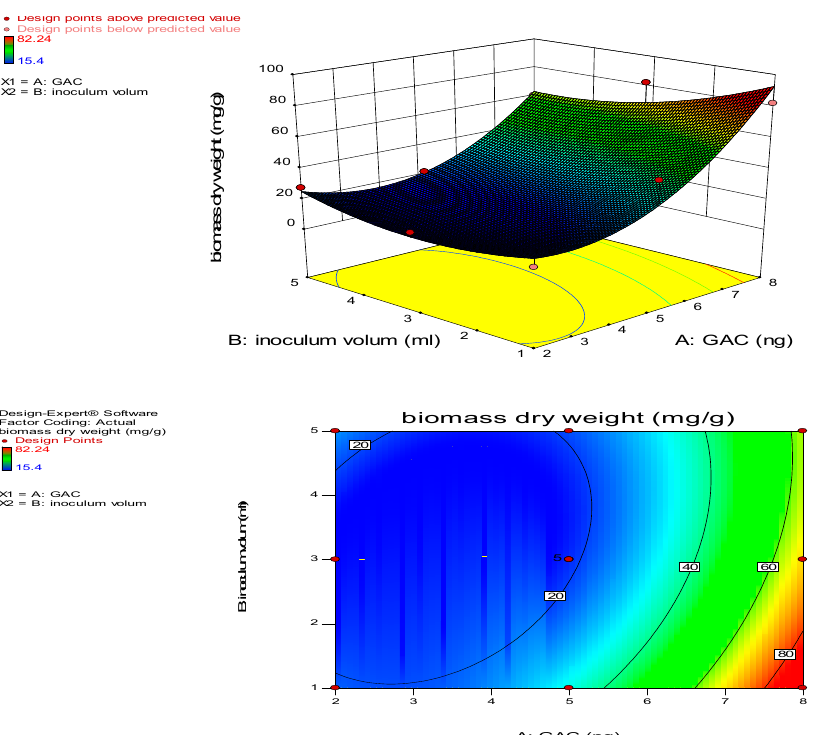
Figure 3. 3D and 2D counter plot graph for optimization of biofilm immobilization.